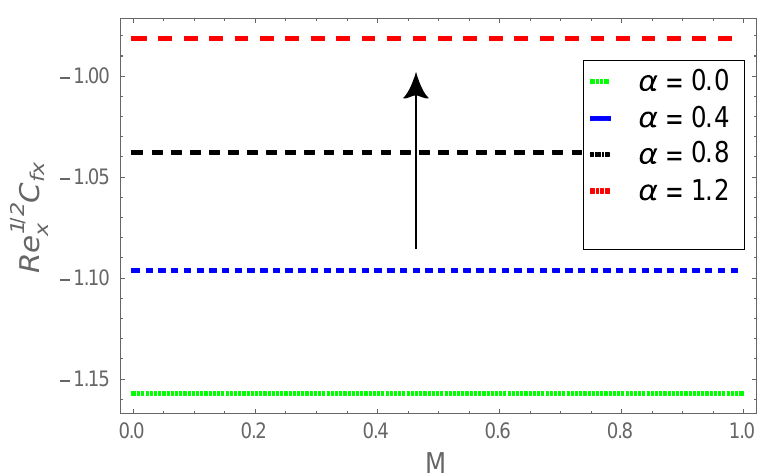
Figure 31. Consequence of